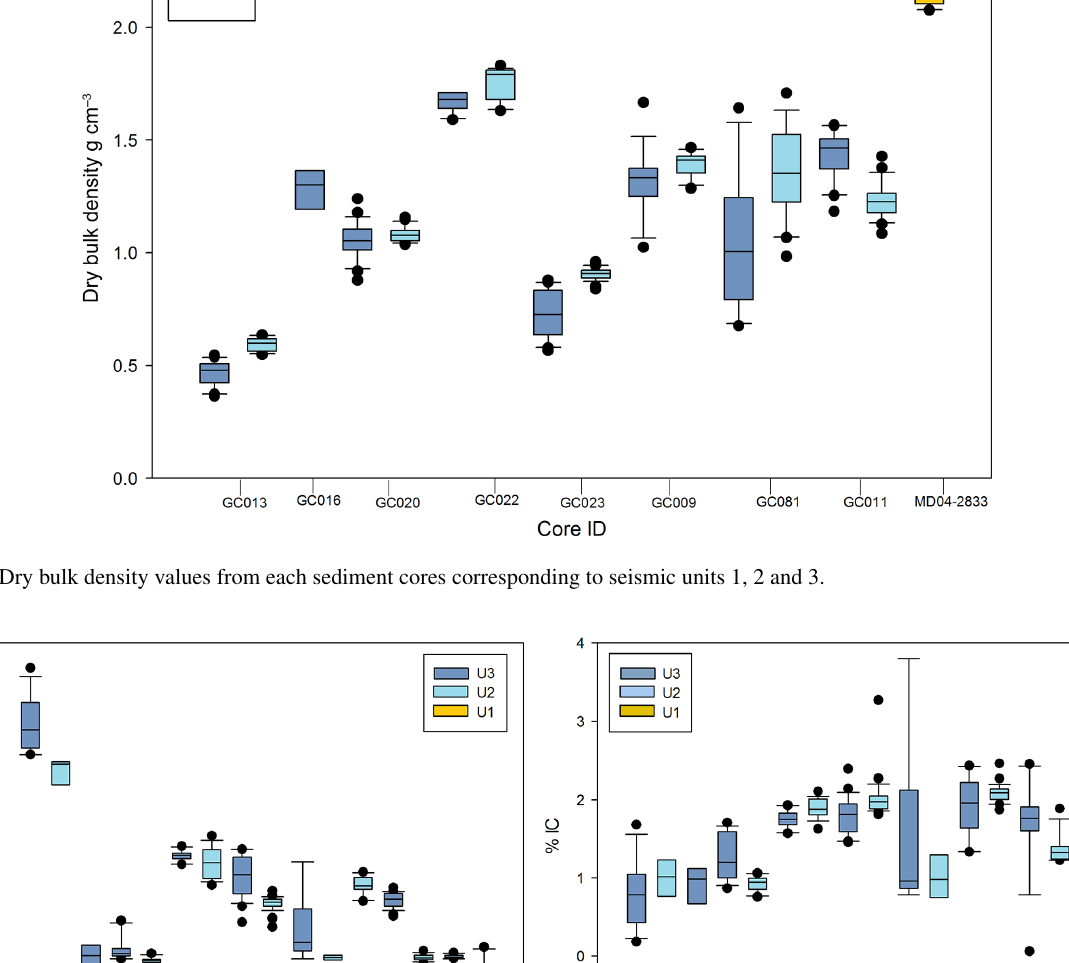
a postglacial C eff of 0.412 Mt C km − 2 and a glacial C eff